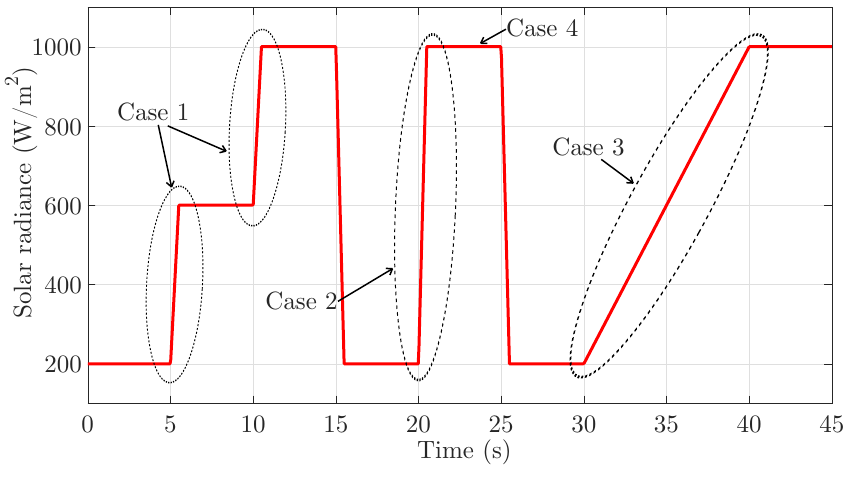
Figure 15. Waveform of solar